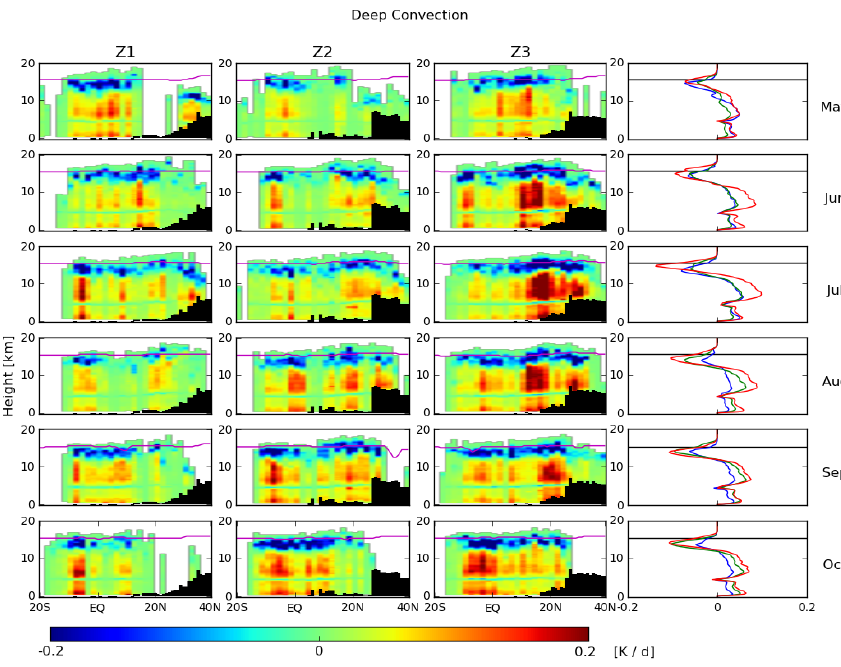
Figure 8. The monthly evolution of CRH due to deep convective clouds. The magenta-coloured lines show the level of zero net clear-sky radiative heating